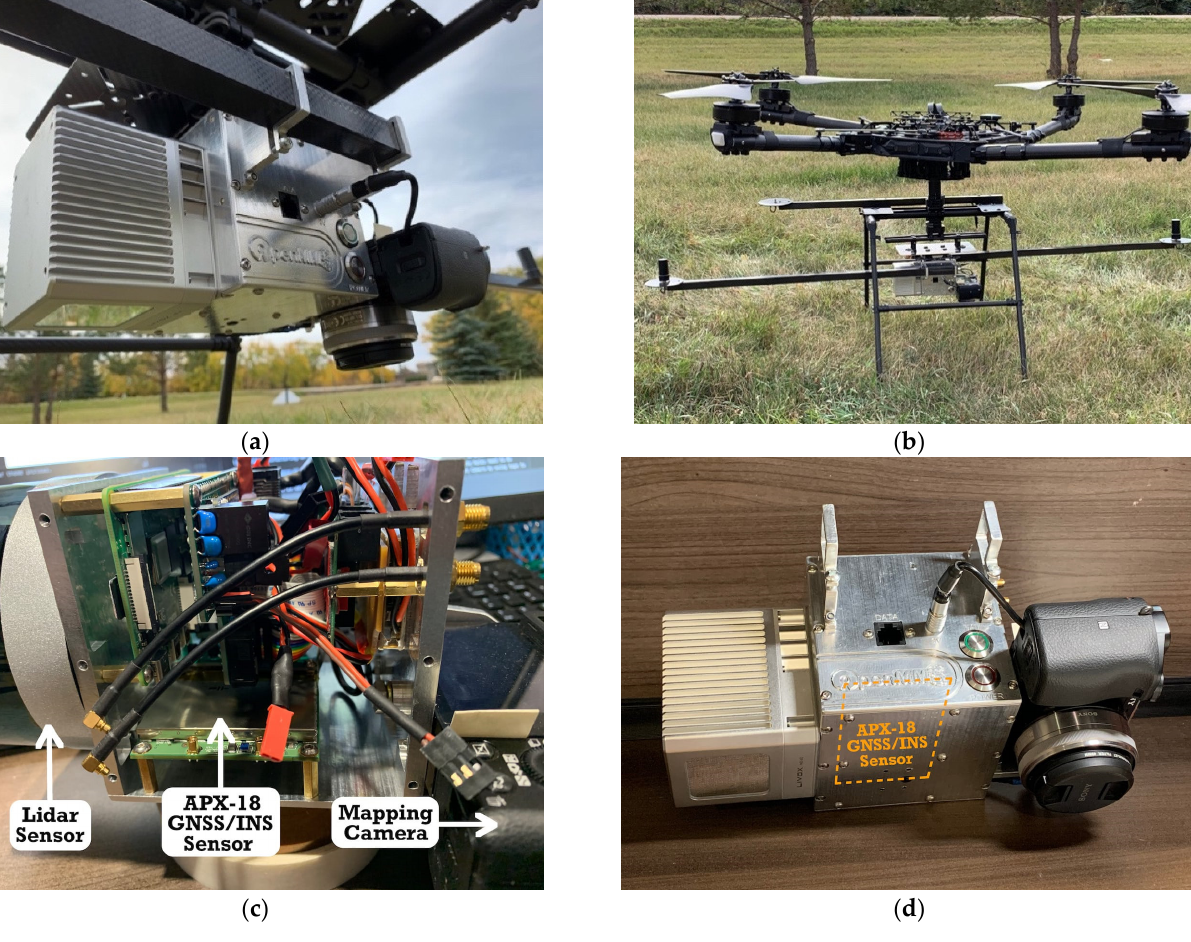
Figure 6. ( a ) OpenMMS UAS-lidar mapping system used in this study. ( b ) Mapping system installed on a Freefly Systems Alta X UAS. ( c ) Internal configuration of the APX-18 GNSS/INS sensor. ( d ) Relative positions of the mapping sensors.